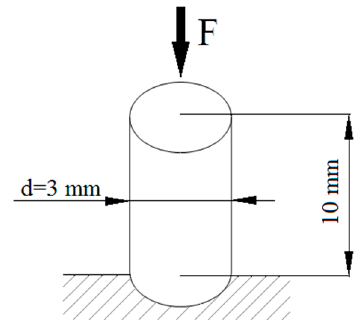
Figure 2. Measurement layout of measuring foam strength.